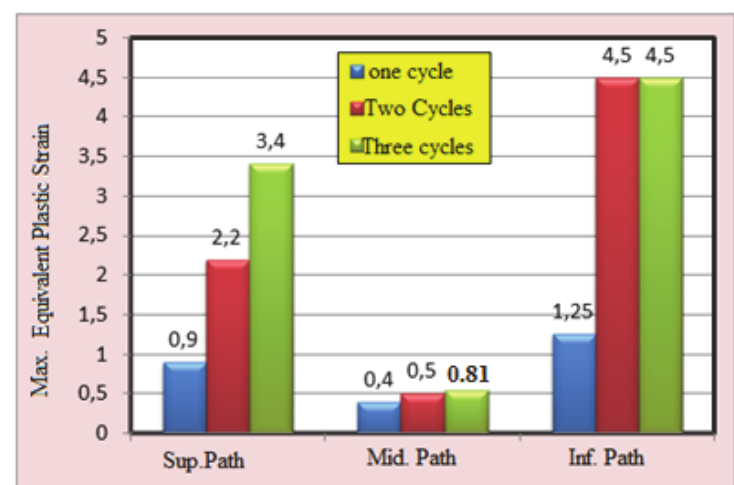
Figure 11: Evolution of maximal equivalent plastic strain along the selected paths, for different numbers of cycles.